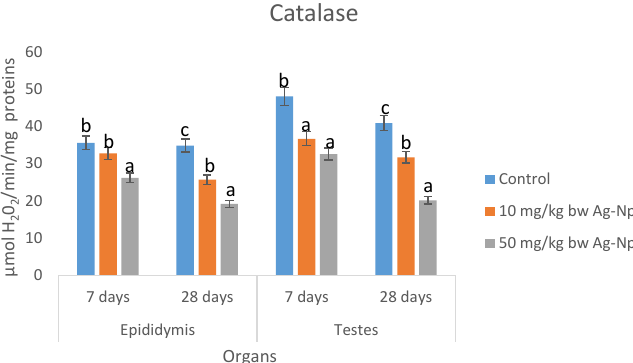
Figure 7. Effects of sub-dermal administration of Ag-NPs on catalase activity in the testis and epididymis of rats. Each bar represent mean ± standard deviation of triplicate determination. Bars with different superscript alphabet are significantly different ( p < 0.05). The high significant levels of the parameters were in the order of a < b < c. Data with superscript alphabet “a” are significantly lower than data with superscript alphabet “b” while data with superscript “b” are lower than data with superscript alphabet “c” at p < 0.05.